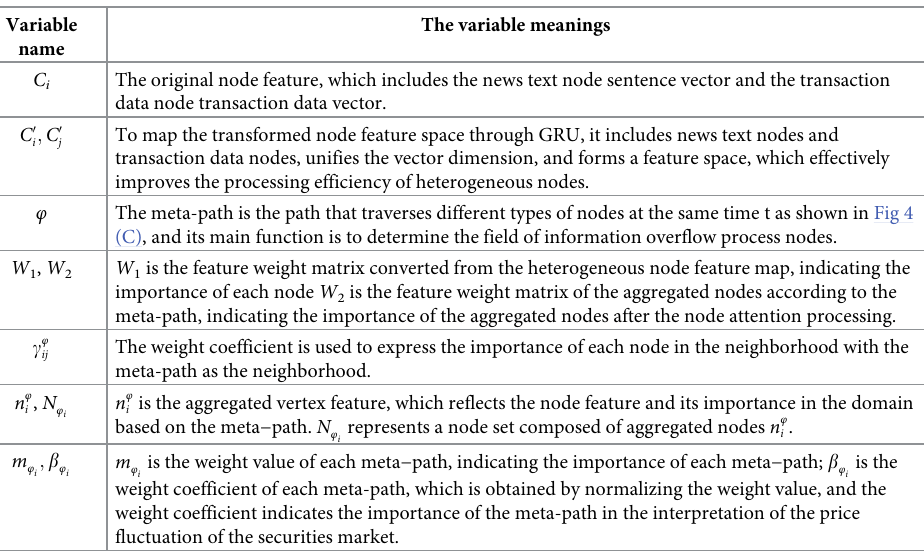
Table 1. Explain variable names and